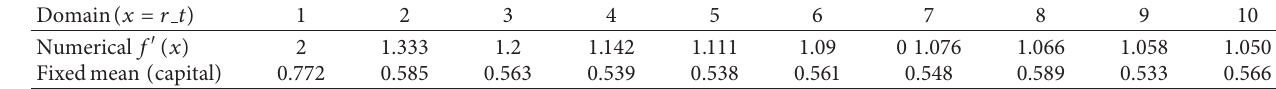
Table 6: Numerical result of the function [ f ′ ( x )